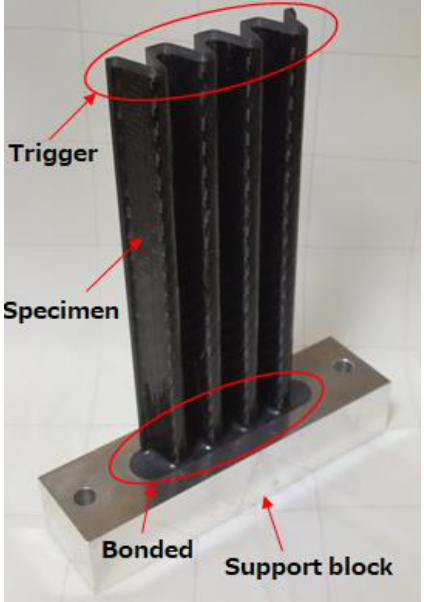
Figure 8. Corrugate structure with support block.